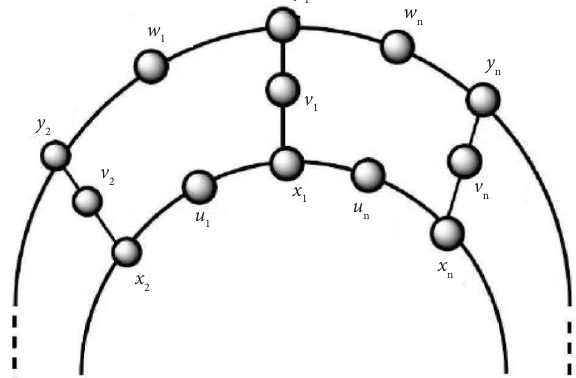
Figure 1: Barycentric subdivision of cayley graphs S ( Cay ( Z